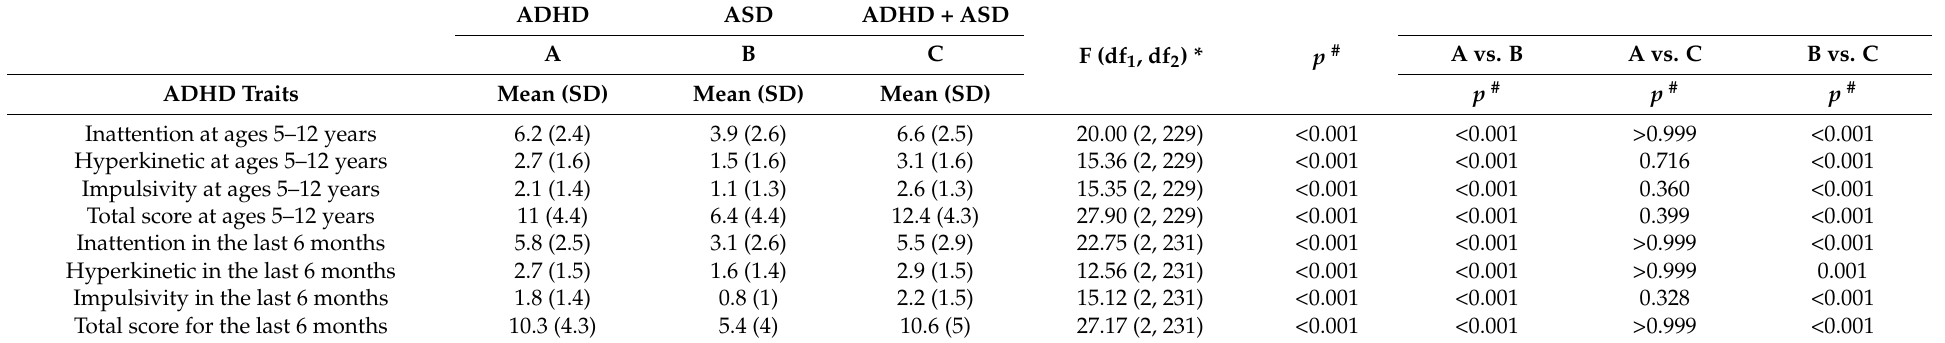
Table 2. Comparison of the self-reported number of ADHD traits between the three study groups.